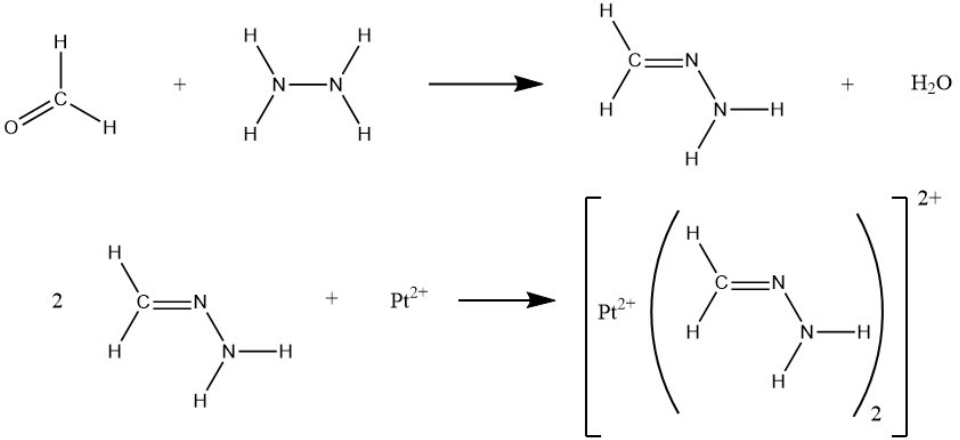
Figure 1. Reaction scheme explaining the adsorptive stripping voltammetric detection of platinum by HMDE with formaldehyde and hydrazine forming a platinum(II) formazone complex that is enriched in the mercury drop electrode under negative